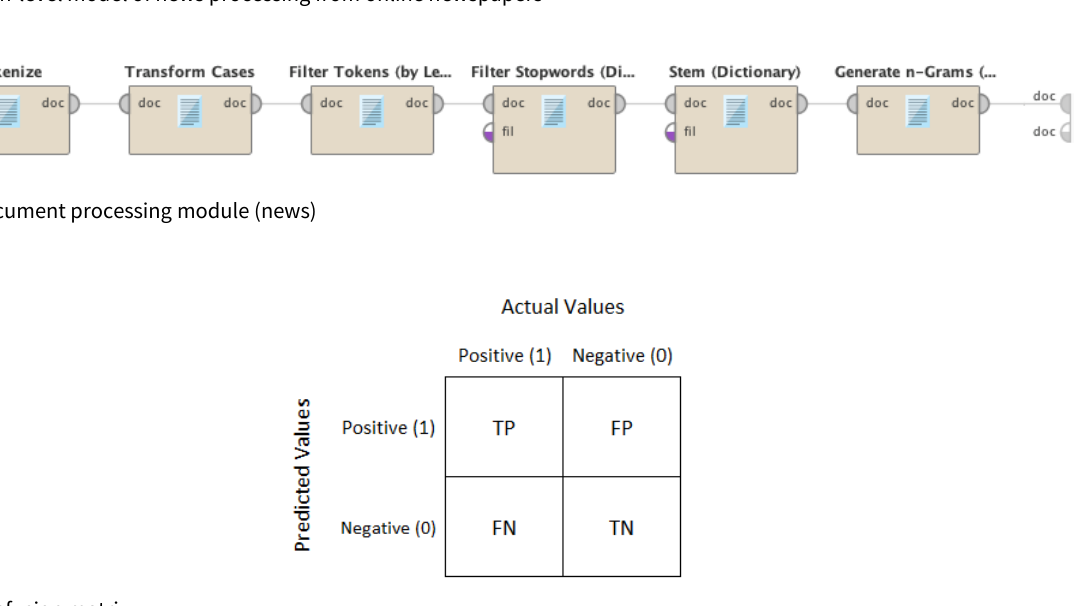
Figure 2. High-level model of news processing from online newspapers